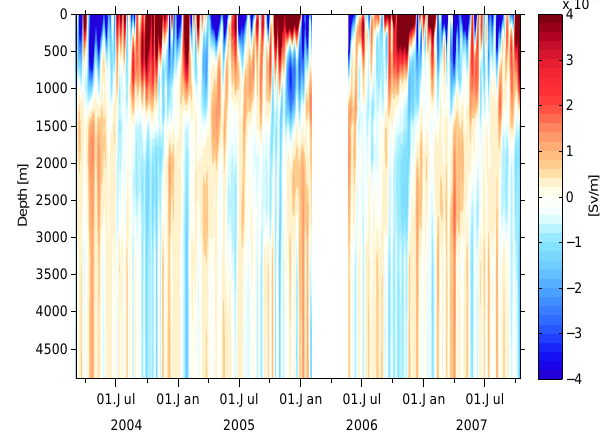
Fig. 9. Anomalies (time mean subtracted) of the transport per unit depth as a function of time and depth, derived from EB1 ( T EB1 and assuming steady western-boundary conditions. The data are 10-day low-pass filtered.